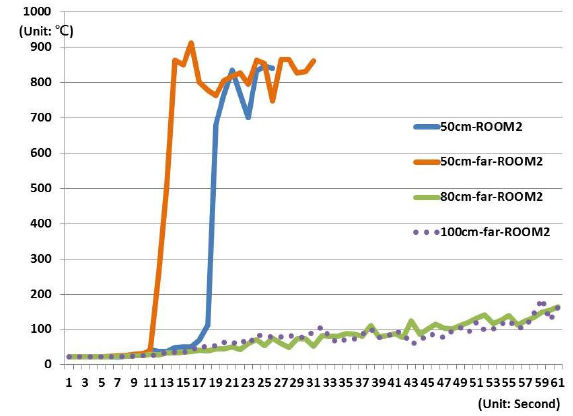
Figure9. Temperature variation occurred in the second room of the left residence.